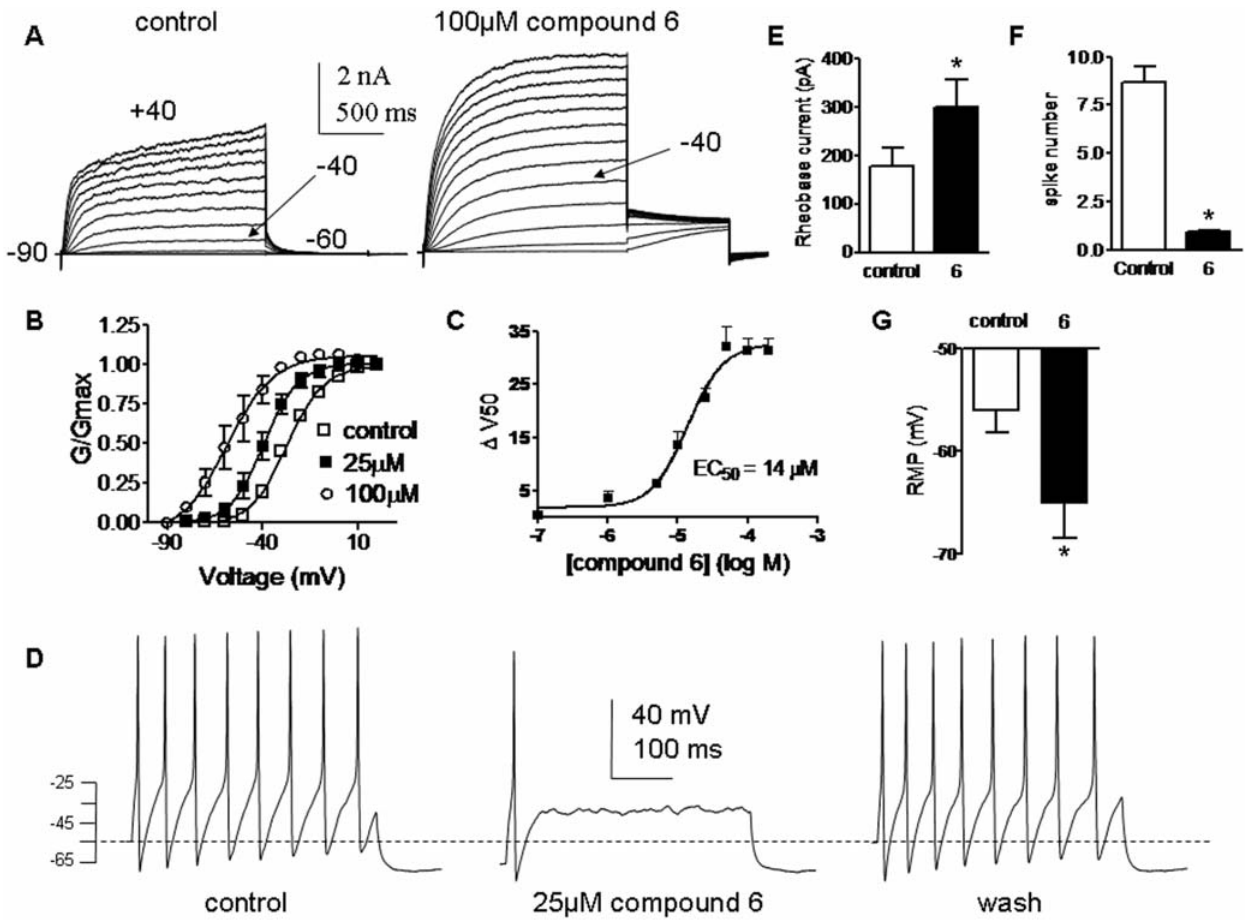
Figure 9. Compound 6 enhances Kv7.2/3 currents and inhibits firing of peripheral DRG neurons. (A) Representative traces recorded from the same CHO cell before (left panel) and after (right panel) external application 100 m M compound 6. The membrane potential was stepped from 2 90 mV (holding potential) to + 40 mV for 1.5 s pulse duration in 10mV increments, followed by a repolarizing step to 2 60 mV. (B) The normalized conductance (G/Gmax) was plotted as a function of the test voltages, for control (open squares), 25 m M (solid squares) and 100 m M (empty circles) compound 6-treated cells. The activation curves were fitted using one Boltzmann function (n=5). (C) The potency of compound 6 was determined by the extent of left-shift ( D V 50 ), plotted as a function of compound 6 concentration and fitted by a sigmoidal function yielding an EC 50 value of 14 6 2 m M (n=5). (D) Representative rat DRG spiking discharge, evoked by a squared depolarizing current pulse (100 pA for 400 msec) before (control), during exposure to 25 m M compound 6 and after washout (wash). (E) Rheobase current necessary to inject (2 ms) into DRG neurons to evoke a solitary spike in the absence and presence of 25 m M compound 6 (n=8; * p , 0.01). (F ) Number of spikes evoked by injecting squared depolarizing current pulses (75–200 pA for 400 ms) in DRG neurons in the absence and presence of 25 m M compound 6 (n=12; * p , 0.01). (G) Resting membrane potential of DRG neurons before (control) and following exposure to 25 m M compound 6 (n=7; * p , 0.01).